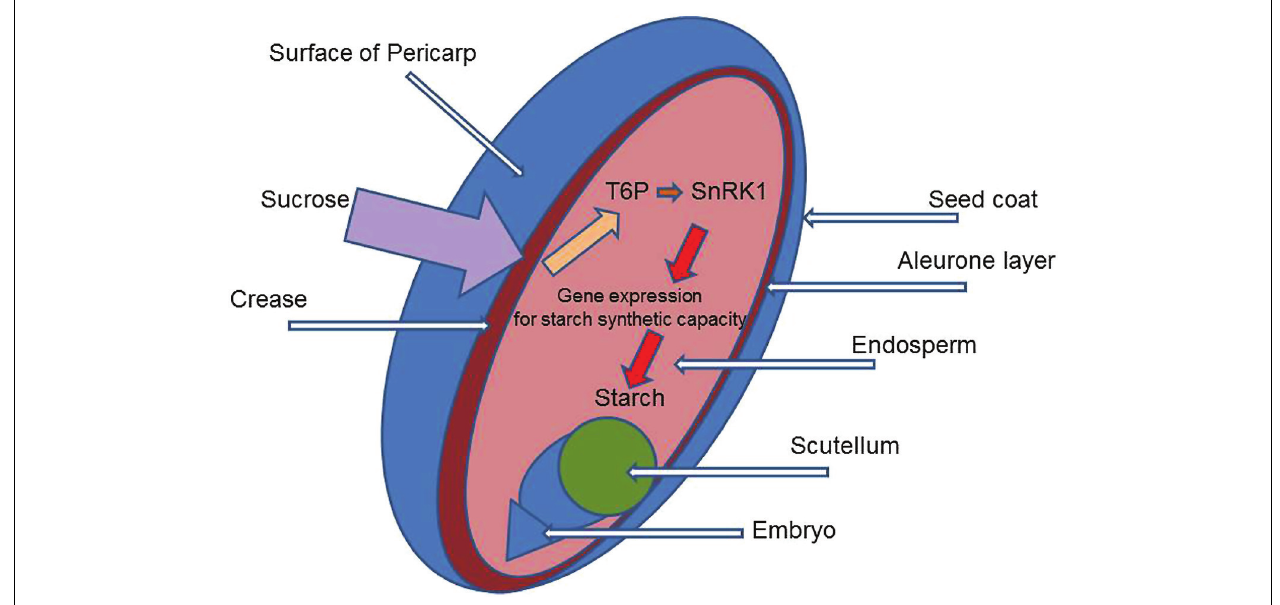
FIGURE 3 | Diagram of a wheat grain identifying the main structural components and site for potentially increasing grain size by alteringTRE/SnRK1 metabolism.